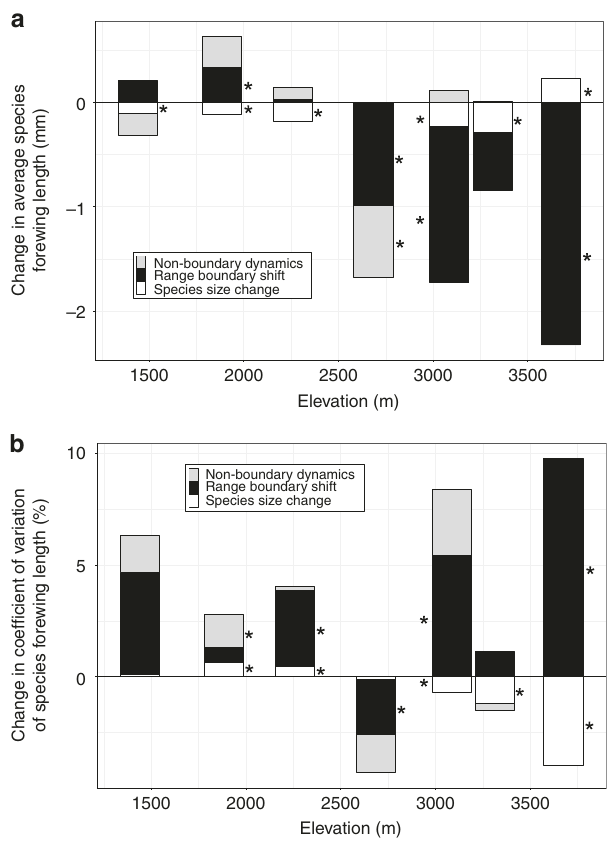
Fig. 3 Contribution of range boundary shifts (black), intraspeci fi c size change (white), and non-boundary dynamics (gray) to changes in moth assemblage size structure from 1965 to 2007. a Change in average species forewing length. b Change in coef fi cient of variation of species forewing length. Asterisks indicate components with effect sizes signi fi cantly different from zero at the 95% con fi dence level, based on 500